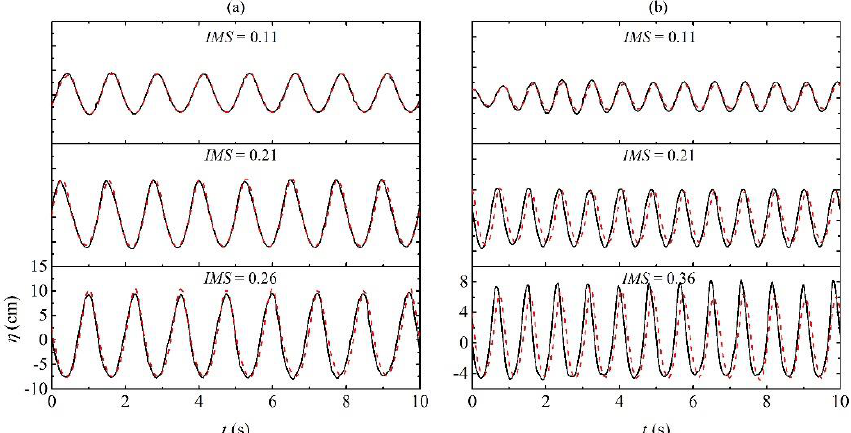
Figure 8. Comparisons of the wave elevations between weakly three-dimensional and oblique two- dimensional experiments after the interaction. ( a ) f = 0.8 Hz; ( b ) f = 1.2 Hz. The black solid lines represent the result measured from the weakly three-dimensional experiment; the red dashed lines represent that from the oblique two-dimensional experiment.